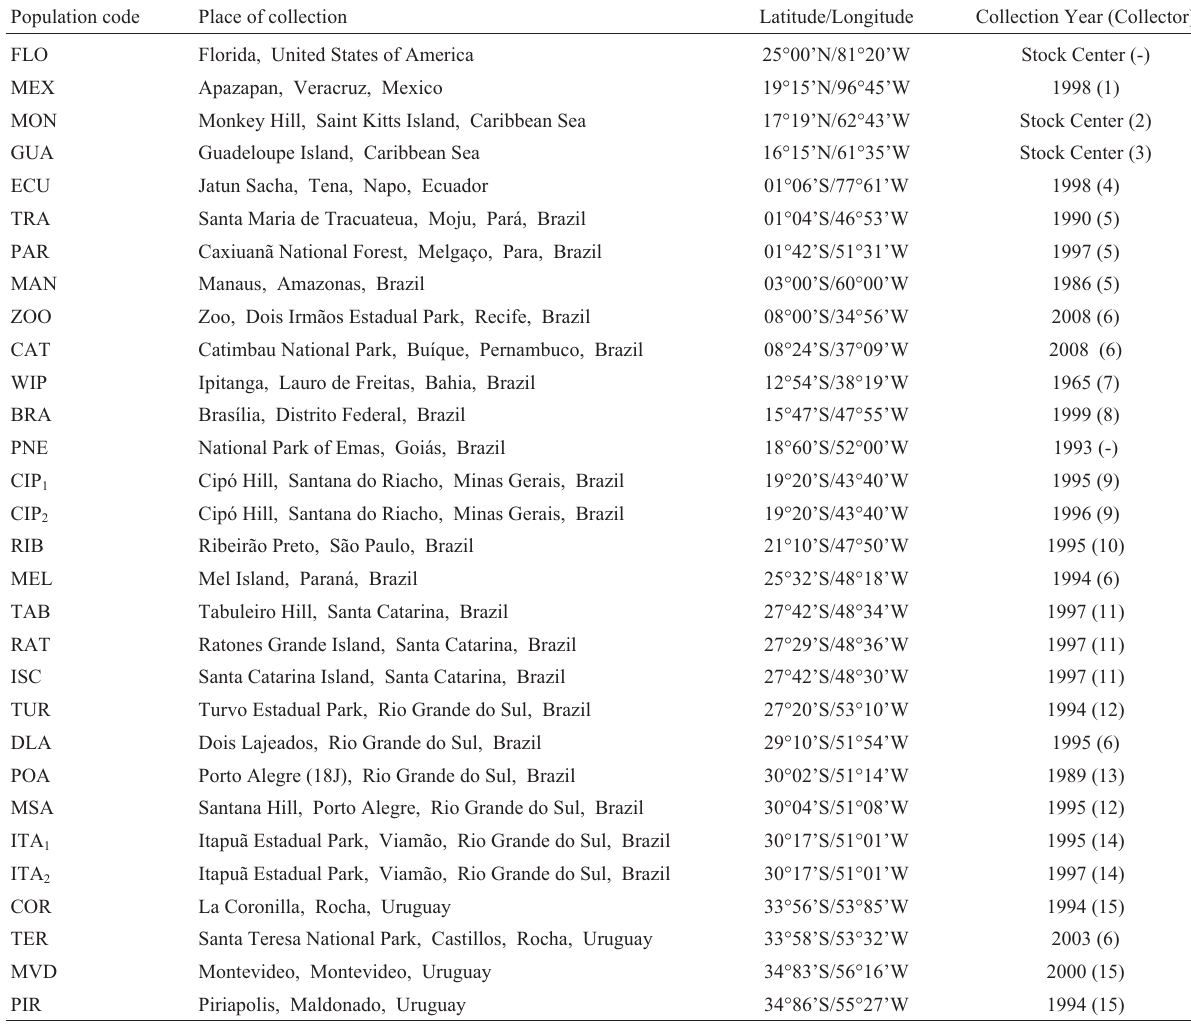
Table 1 - Description of 30 different Drosophila willistoni populations studied for chromosomal polymorphism. Population